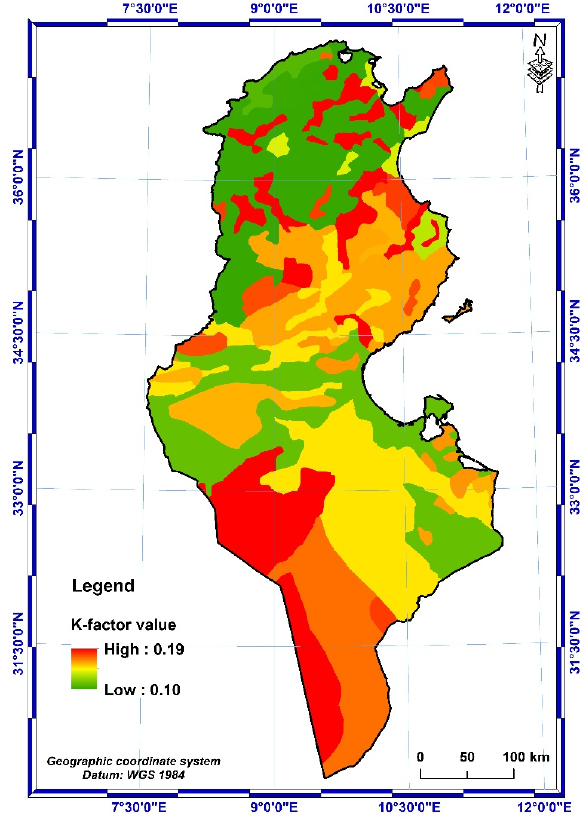
Figure 9. K-factor spatial